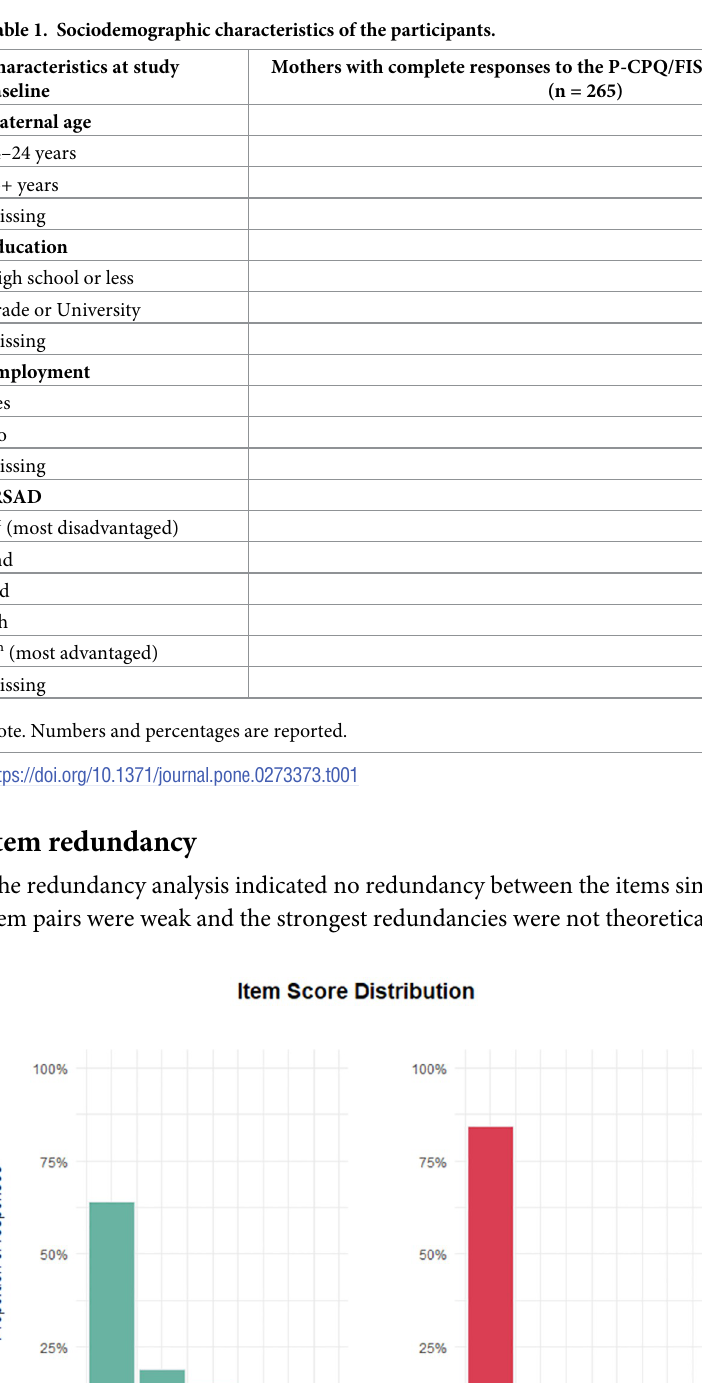
Table 1. Sociodemographic characteristics of the participants.